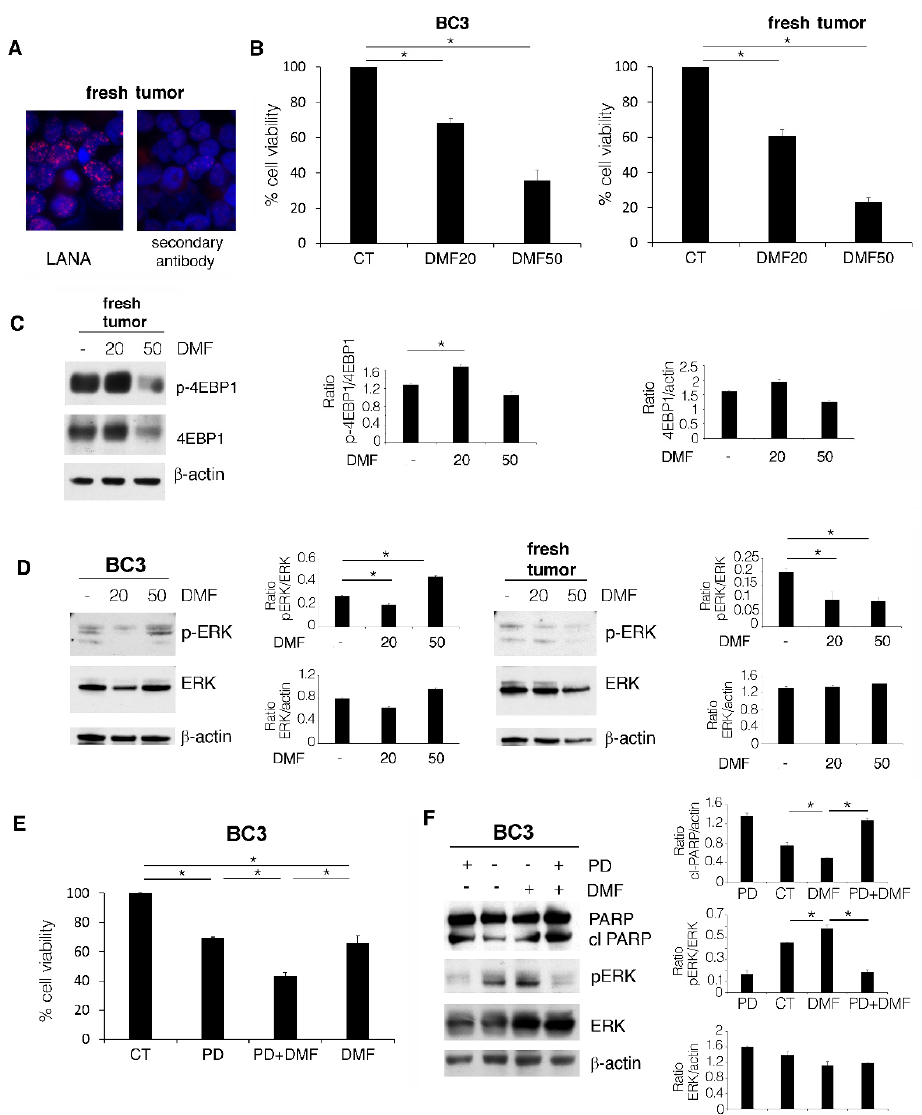
Figure 3. Lack of ERK1/2 activation underlies the higher cytotoxicity of DMF observed in PEL fresh tumors compared to BC3 PEL cell line. ( A ) IFA analysis to relieve LANA1 KSHV latent antigen (red) in PEL fresh tumors. DAPI (blue) was used to stain nuclei. ( B ) Percentage of cell viability of BC3 cells and PEL fresh tumors, treated or not (CT) with 20 and 50 µM DMF for 24 h, evaluated by Trypan blue exclusion assay. ( C ) PEL fresh tumors, treated or not (CT) with 20 and 50 µM DMF for 24 h, were analyzed by western blotting to assess p-4EBP1 level. β -actin was used as loading control, and one representative experiment out of three is shown. The histograms represent the mean plus SD of the densitometric analysis of the p-4EBP1/4EBP1and 4EBP1/ β -actin ratios of three different experiments. ( D ) Western blotting of pERK1/2 in BC3 cells and PEL fresh tumors, treated or not (CT) with 20 and 50 µM DMF for 24 h. β -actin was used as loading control, and one representative experiment out of three is shown. The histograms represent the mean plus SD of the densitometric analysis of the pERK1/2/ERK1/2 and ERK1/2/ β -actin ratios of three different experiments. ( E ) Percentage of cell viability of BC3 cells, treated with 50 µM DMF or not (CT) in the presence of 20 µM PD98059 EK1/2 inhibitor for 24 h. ( F ) PARP cleavage (cl PARP) evaluated by western blotting of BC3 cells, treated or not (CT) with 50 µM DMF for 24 h. β -actin was used as loading control, and one representative experiment out of three is shown. The histograms represent the mean plus SD of the densitometric analysis of the cl PARP/ β -actin ratio of three different experiments. In the figure, mean ± standard deviation (SD) of three independent experiments is shown. * p < 0.05.